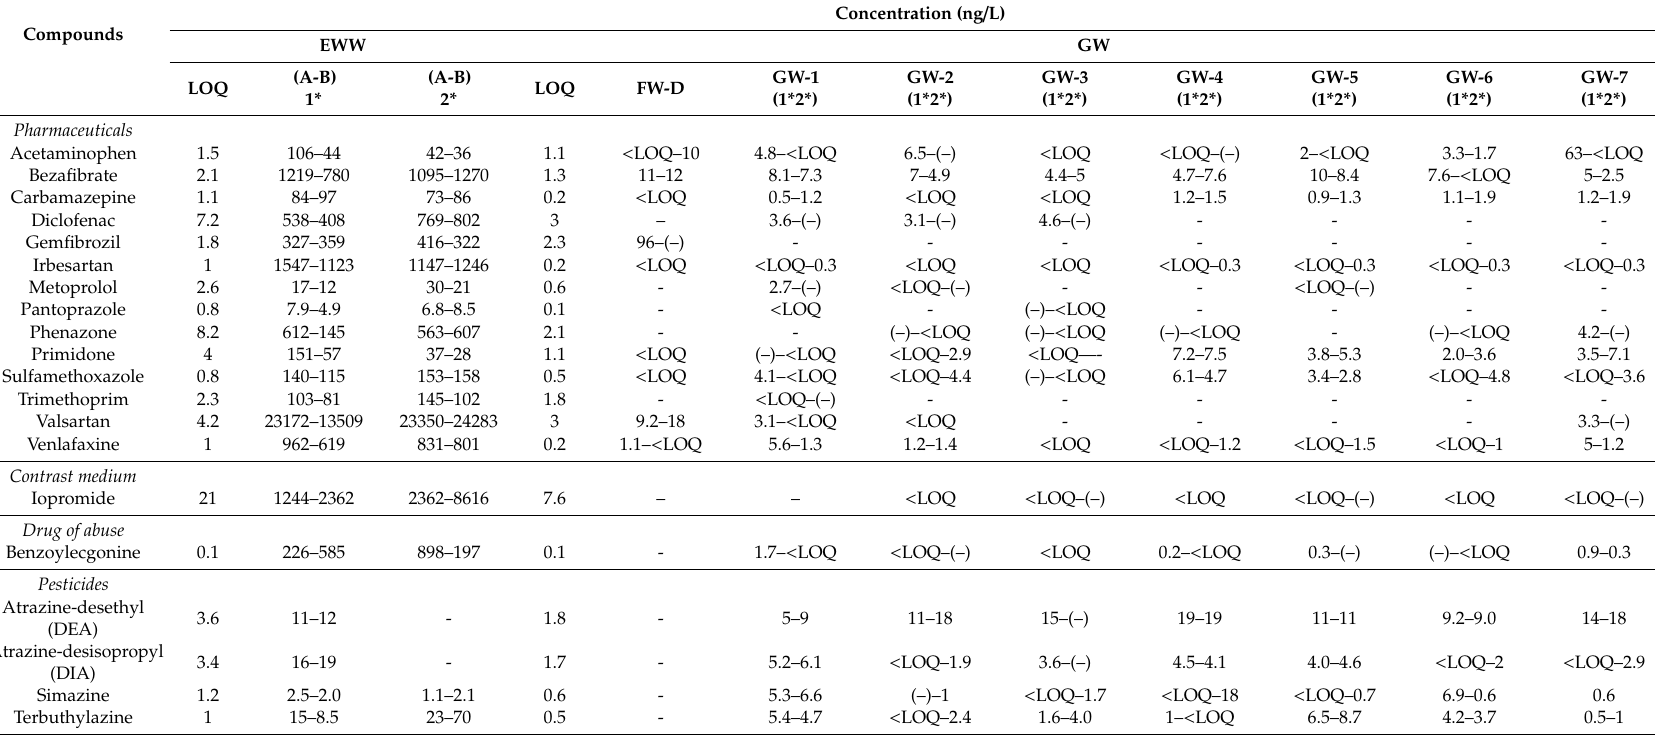
Table 3. The concentration of emerging contaminants (ECs) and pesticides analyzed in EWW, FW, and GW samples (2 sampling periods).